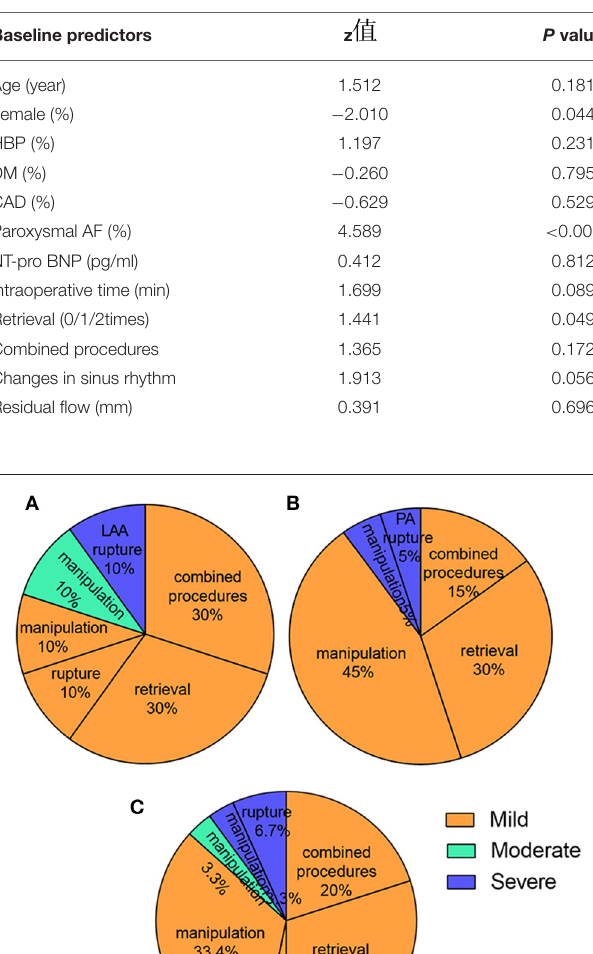
TABLE 5 | The predictors for pericardial effusion (Logistic regression analysis).